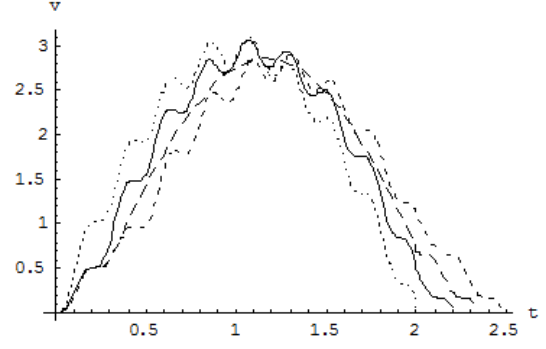
Figure 21: The influence of the vehicle length for R = 50 m, υ = 30 m/s, e H = 3.00 m, e V = 1.20 m and d = 3 m ( __ ), d = 5 m ( _ _ ), d = 7 m (- - - ) and d = 0 m ( .... ).